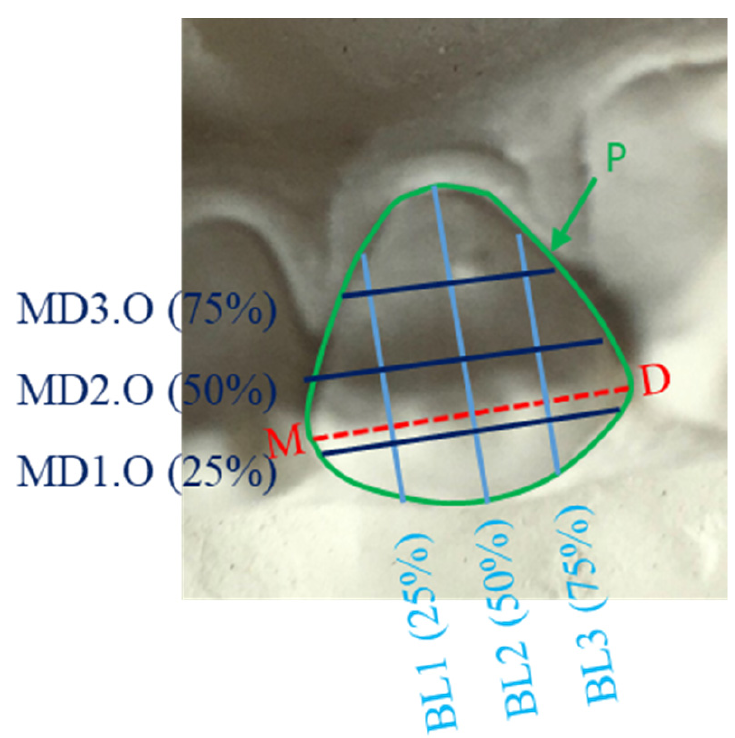
Figure 3. Occlusal view of a lower left lateral incisor measurements: BL1, BL2, BL3 are bucco-lingual dimensions at 25, 50 and 75% along the MD, respectively. MD1.O, MD2.O and MD3.O are mesio-distal dimensions at 25, 50 and 75% along a line bisecting the MD.